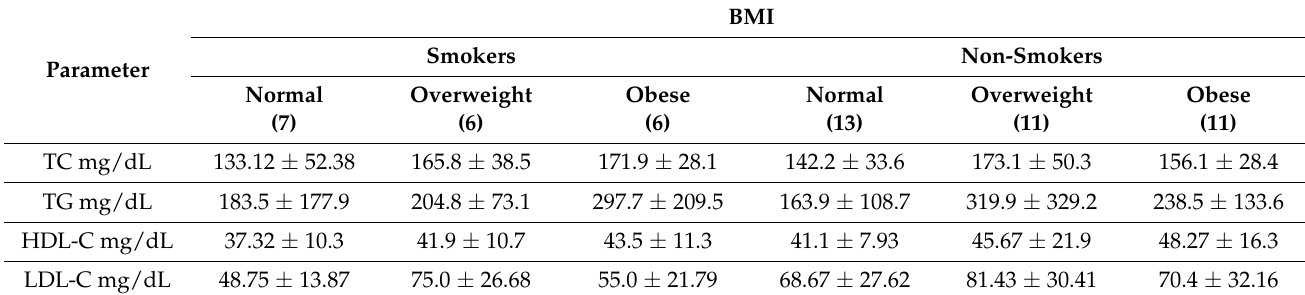
Table 5. Effect of BMI on calculated parameters’ mean values for smokers and